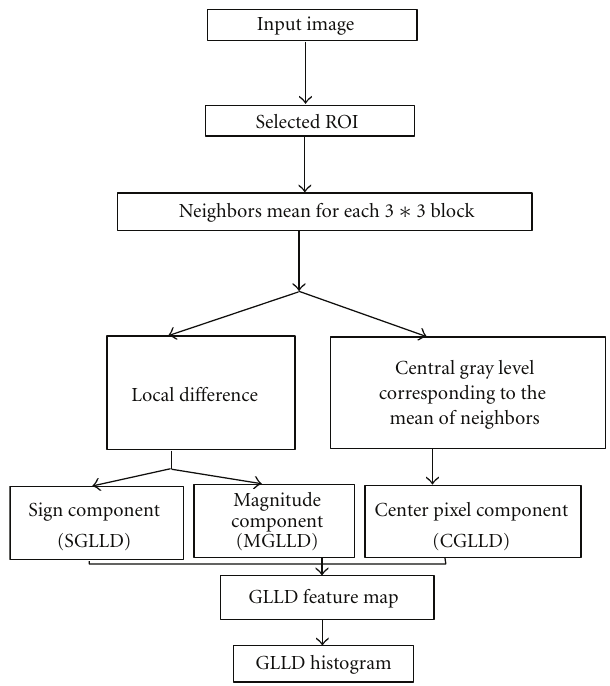
Figure 4: Di ff erent processing steps of of the proposed GLLD based